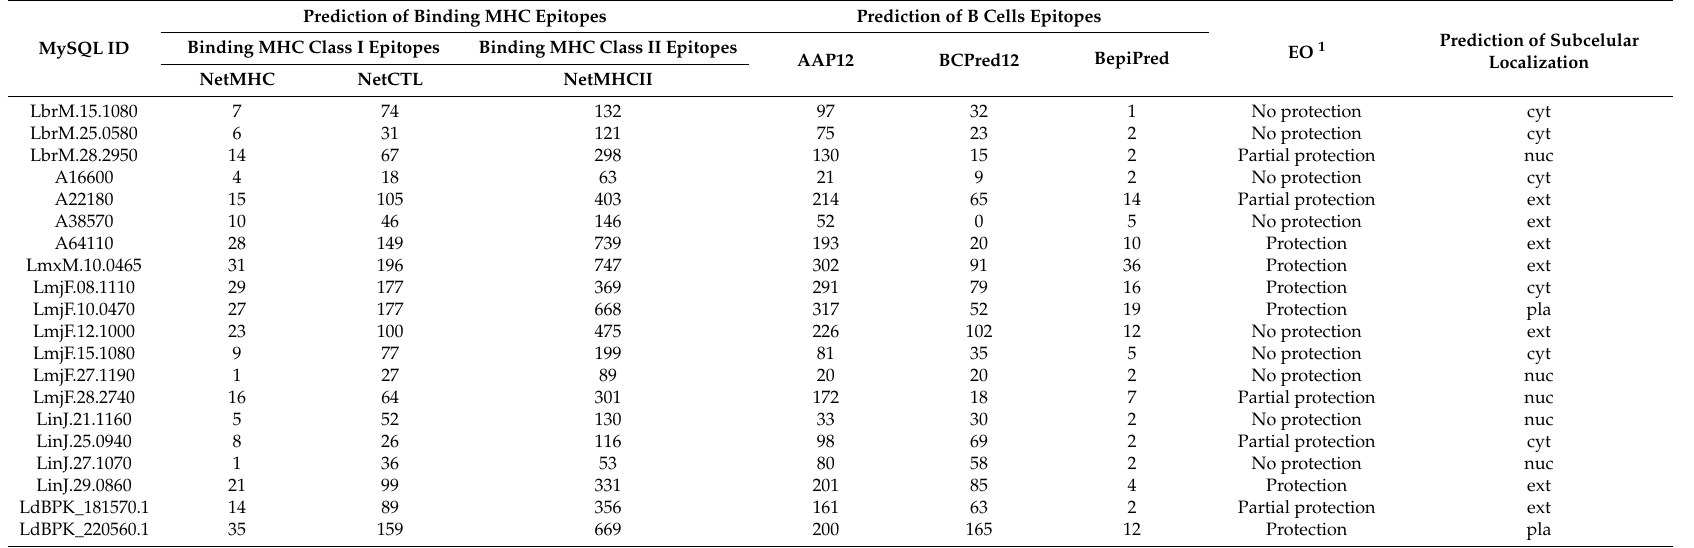
Number of binding Major Histocompatibility Complex (MHC) epitopes, B cell epitopes and subcellular localization predicted by different computational